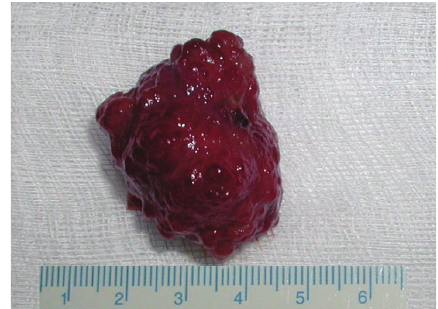
Figure 6: Cavernous lymphangioma of the